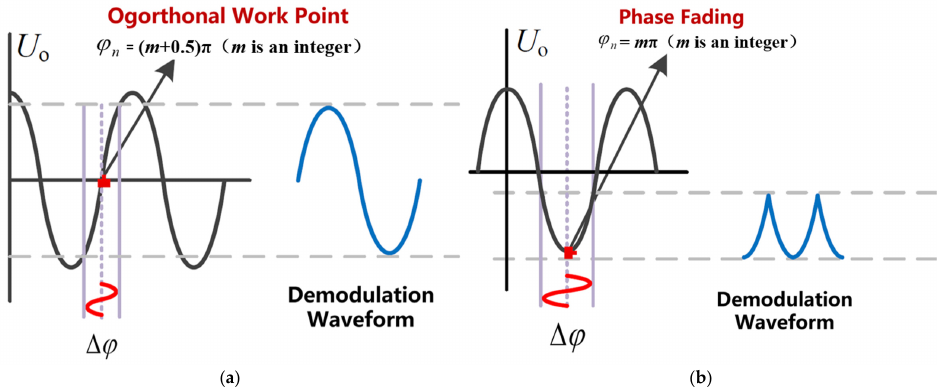
Figure 2. Schematic diagram of the mechanism for affecting the sensing system stability. ( a ) or- thogonal work point. ( b ) phase fading work point.